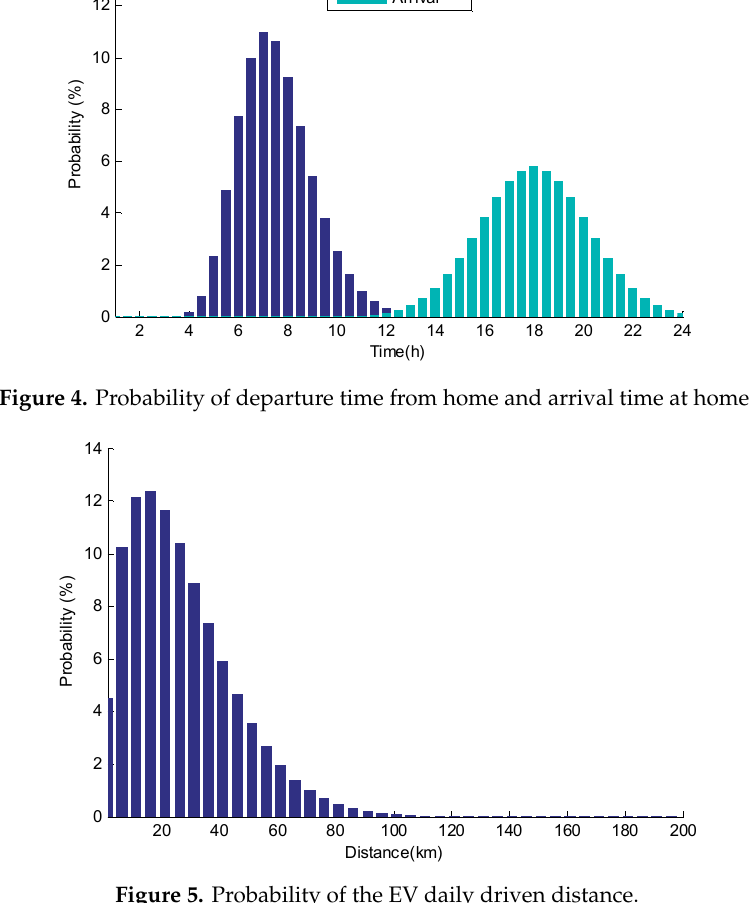
Figure 5. Probability of the EV daily driven distance.